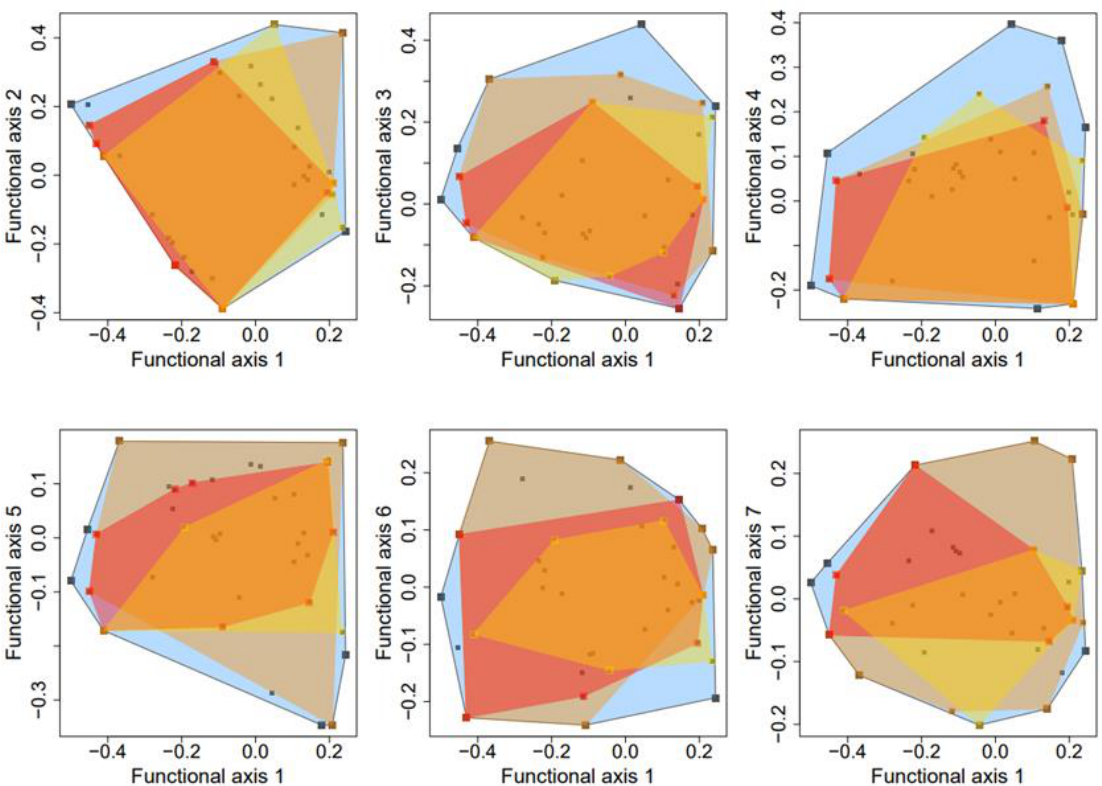
Figure 2. The PCoA ordination describes the functional space (blue) of the 71 aquatic fungal species and illustrates the reduction in functional diversity across the increased drying conditions from locations with permanent flow (light red polygon) to those with intermittent (dark red polygon) and ephemeral (yellow polygon)